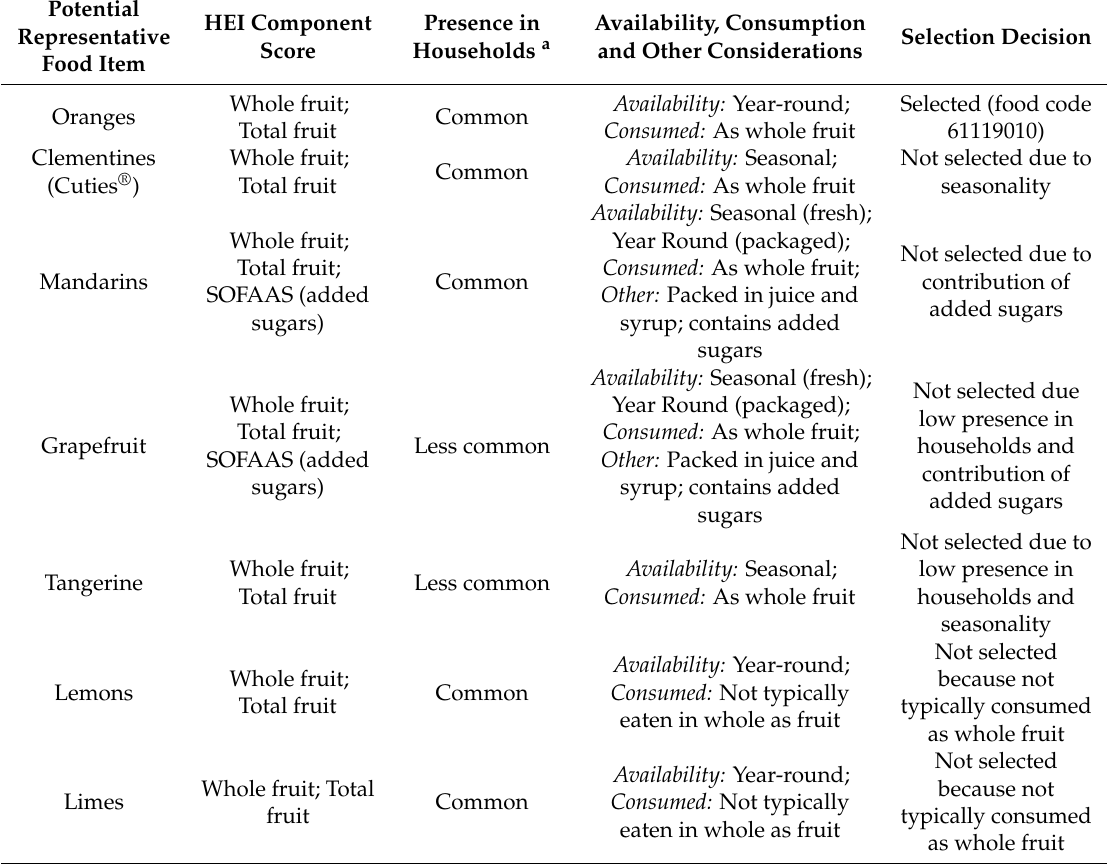
Table 2. Sample considerations for the selection of the representative food for Home-IDEA2 Category of citrus